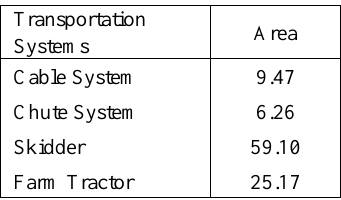
Table 8. The areal distribution (%) of transportation methods